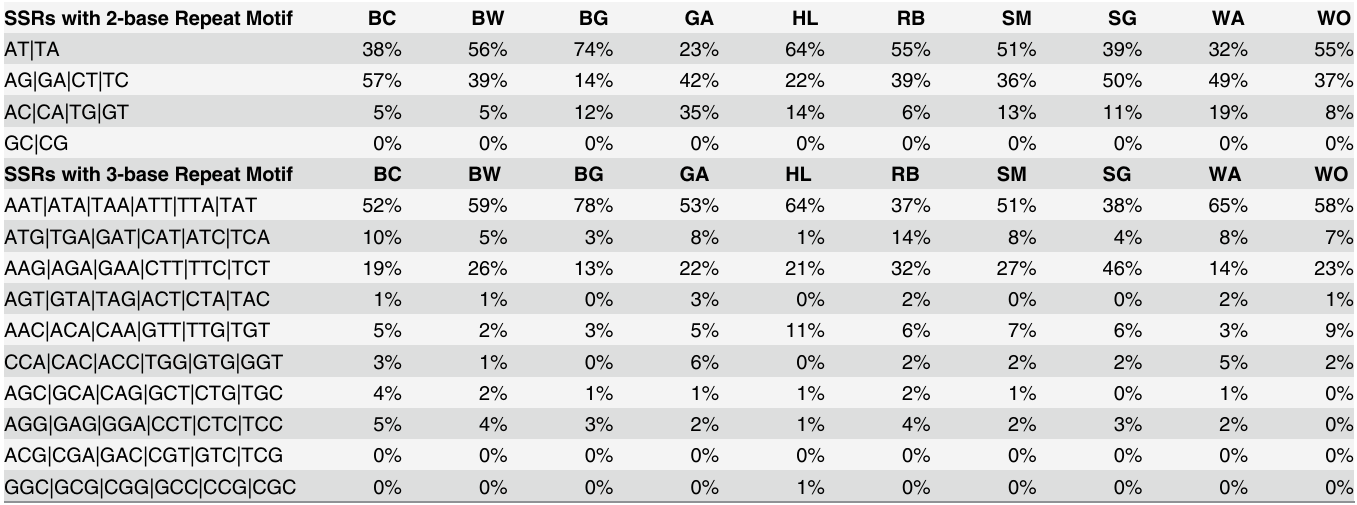
Table 5. Frequency of repeat patterns for two base pair and three base pair motif gSSRs. For both 2- and 3-base pair repeat motifs, repeats with a lower GC% was more commonly found. Shifted and reverse complement motifs were merged into a single category; e.g. AG shifted by a single base is GA, and on the reverse strand is CT or TC. Abbreviations: BC = black cherry, BW = black walnut, BG = blackgum, GA = green ash, HL = honeylocust, RB = redbay, SM = sugar maple, SG = sweetgum, WA = white ash, WO = white oak. SSRs with 2-base Repeat Motif